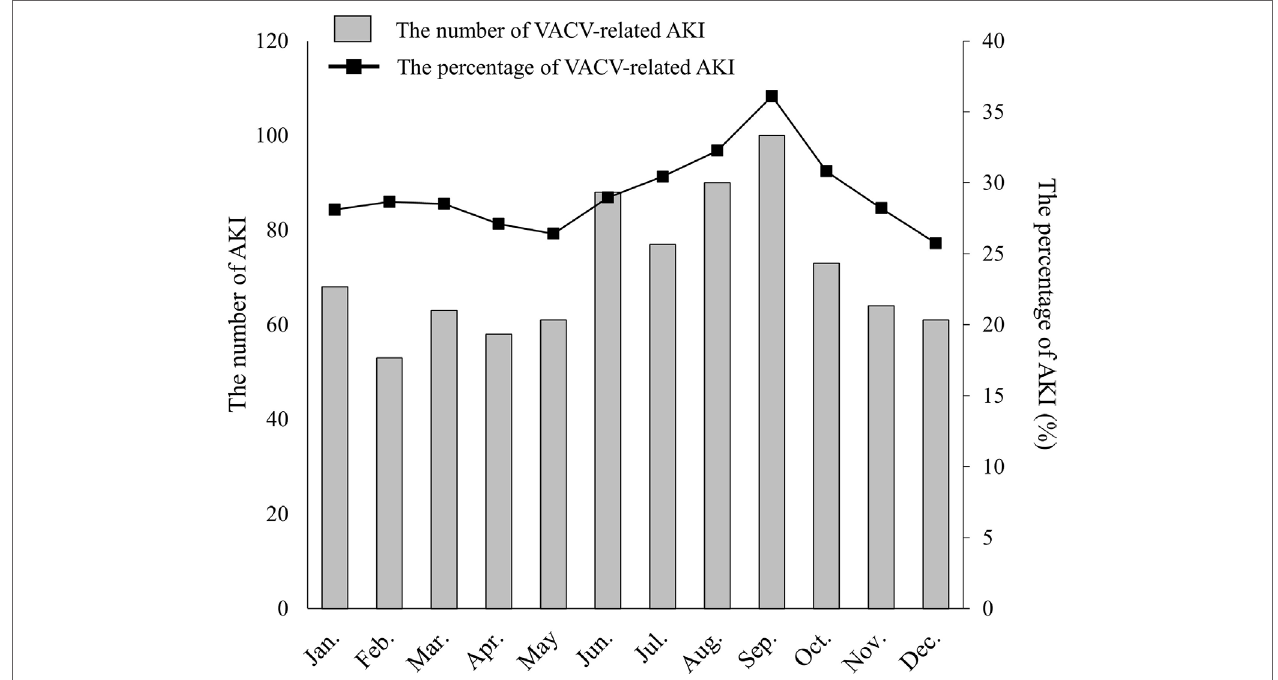
FIGURE 1 | Seasonal distribution of VACV-related AKI. The number of VACV-related AKI cases by month is indicated as shaded columns. The percentage of AKI cases versus all VACV-related adverse events is indicated by the line graph (solid line).